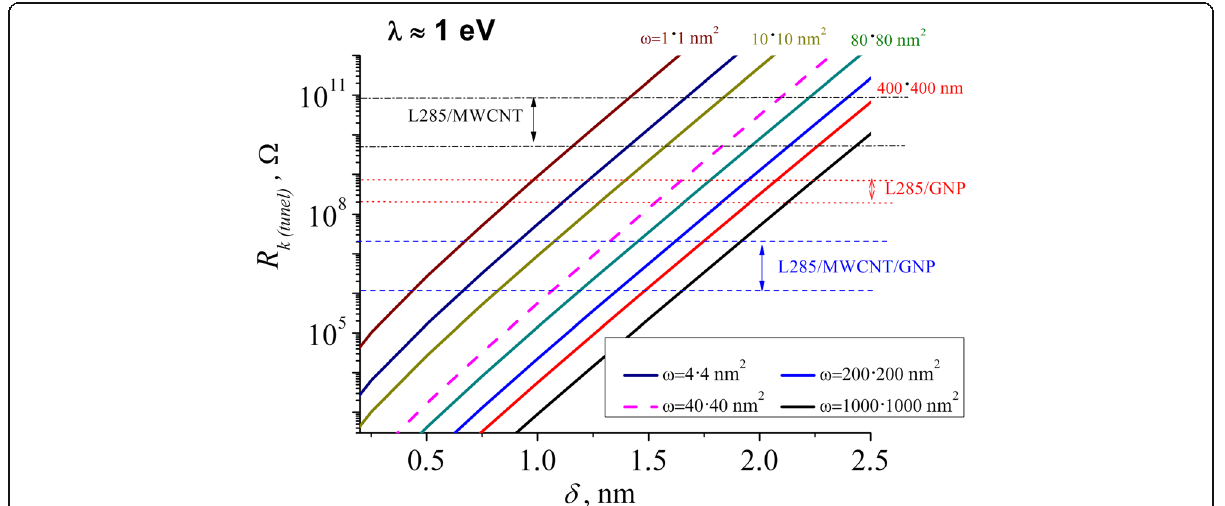
Fig. 7 The dependences of the contact resistance on the thickness of the polymer layer between the filler particles for various values of the cross-sectional tunneling